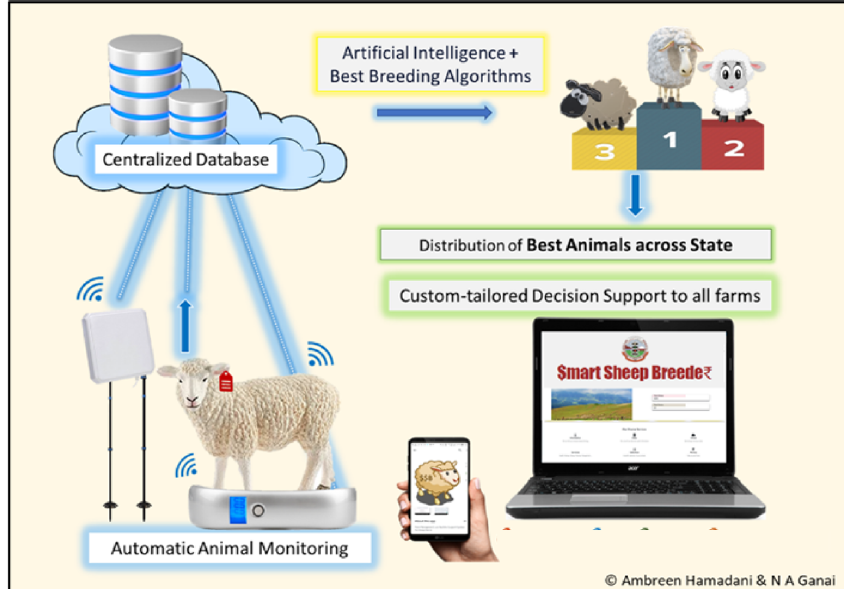
Figure 2. Smart Sheep Breeder and its potential.